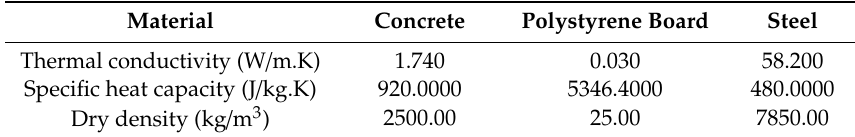
Table 6. Thermal conductivity, specific heat capacity, and dry density of the main materials in the simulation.